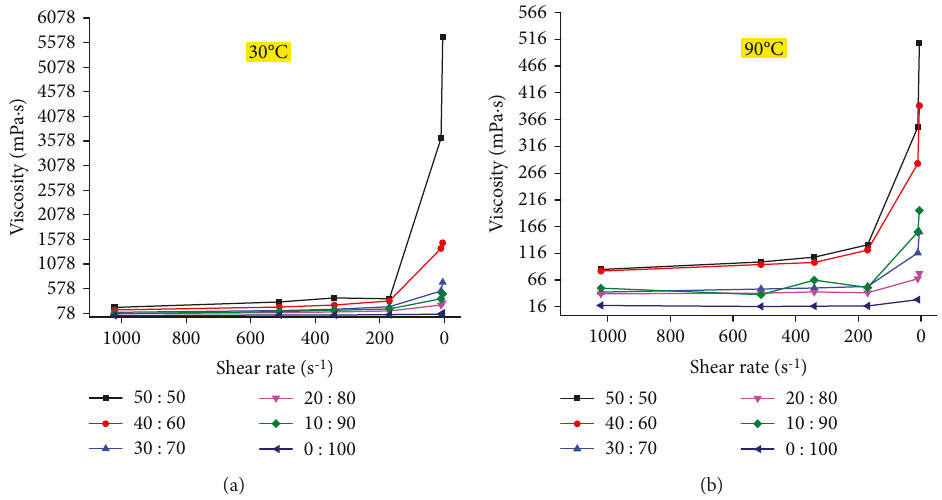
Figure 4: The relationship between apparent viscosity and shear rate at di ff erent temperatures.